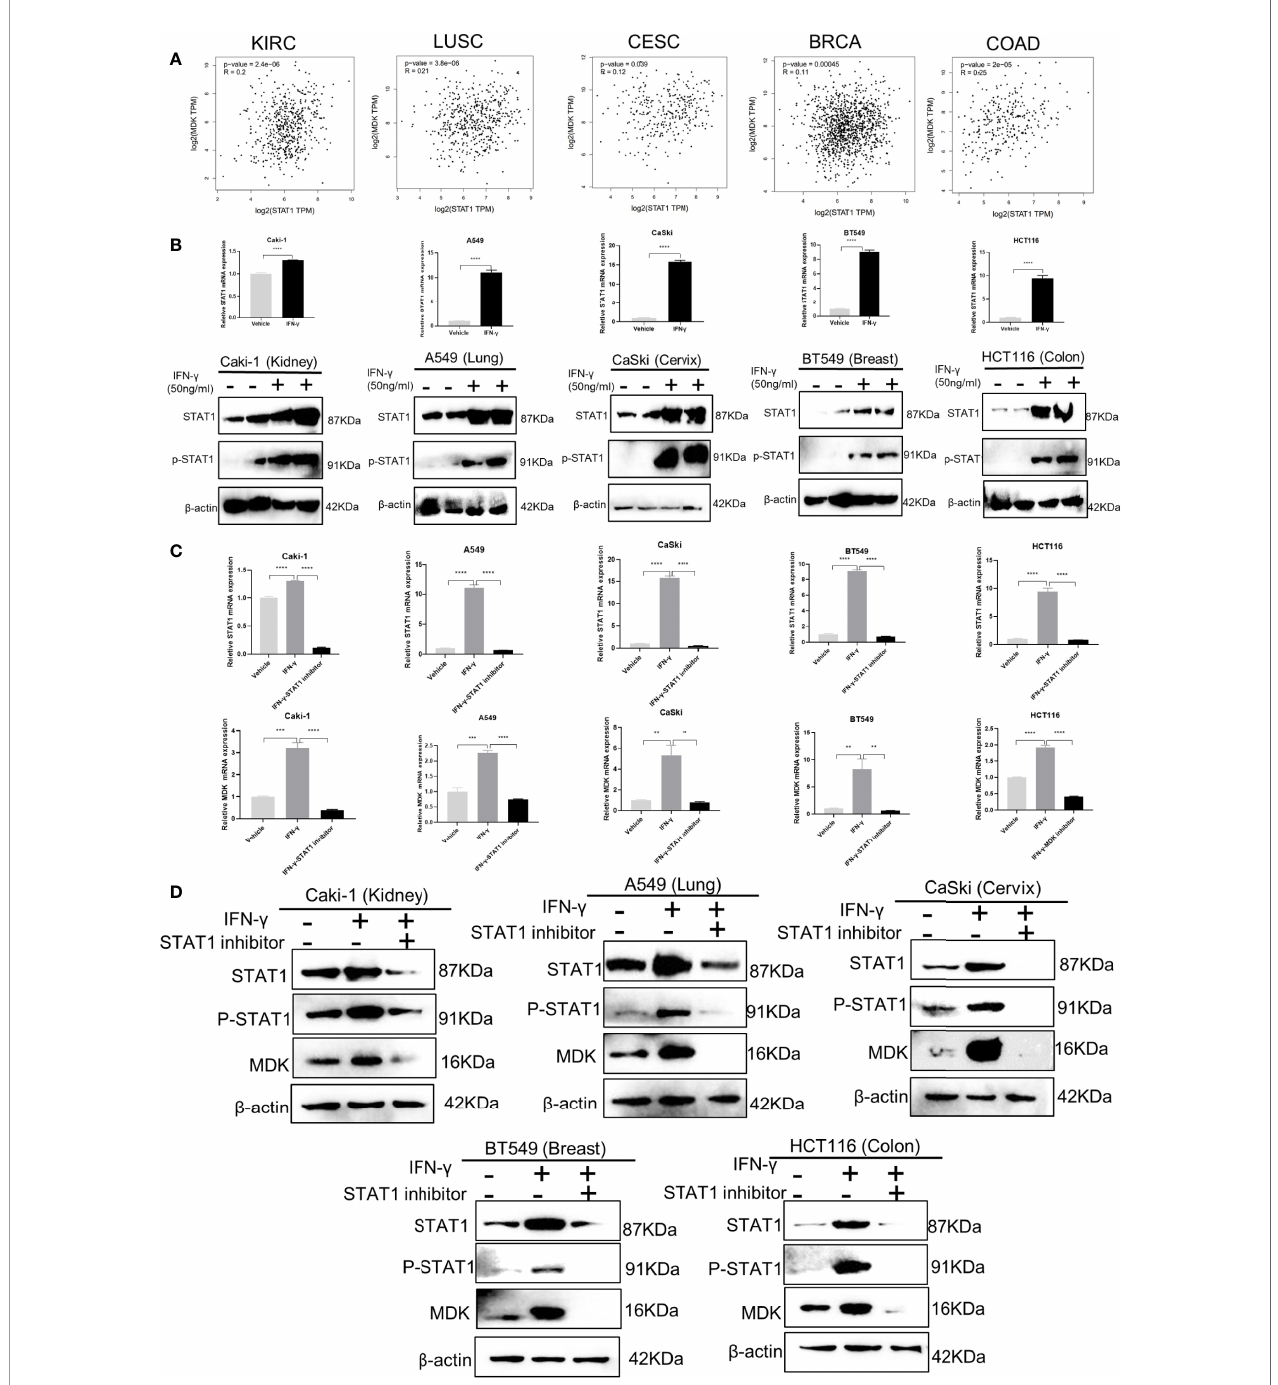
FIGURE 4 | IFN- g activates MDK via STAT1. (A) Correlation analyses using the GEPIA 2 online tool (http://gepia2.cancer-pku.cn/#correlation) to shown the correlation relationship between STAT1 and MDK using the RNA-seq data of different cancers from the Cancer Genome Atlas (TCGA) database. KIRC, kidney renal clear cell carcinoma; LUSC, Lung squamous cell carcinoma; CESC, Cervical squamous cell carcinoma and endocervical adenocarcinoma; BRCA, breast invasive carcinoma; COAD, colorectal adenocarcinoma. (B) RT-qPCR and Western blotting assays to detect the effect of IFN- g treatment (50 ng/ml, 48h) on levels of STAT1 and phosphorylated STAT1 (p-STAT1) in fi ve cancer cell lines. (C) RT-qPCR assays to the effect of STAT1 inhibitor on mRNA levels of STAT1 and MDK in fi ve cancer cell lines. (D) Western blotting assays to examine the effect of STAT1 inhibitor on protein levels of STAT1, p-STAT1 and MDK in fi ve cancer cell lines. Data are shown as the mean ± standard deviation (SD). **P < 0.01, ***P < 0.001, ****P <